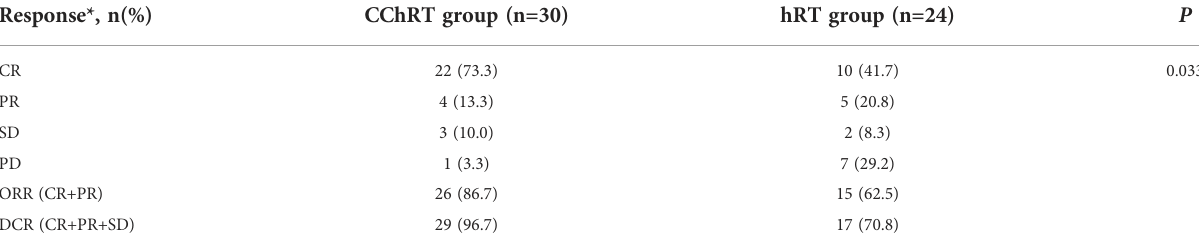
TABLE 2 Summary of Tumor Responses (n=54).